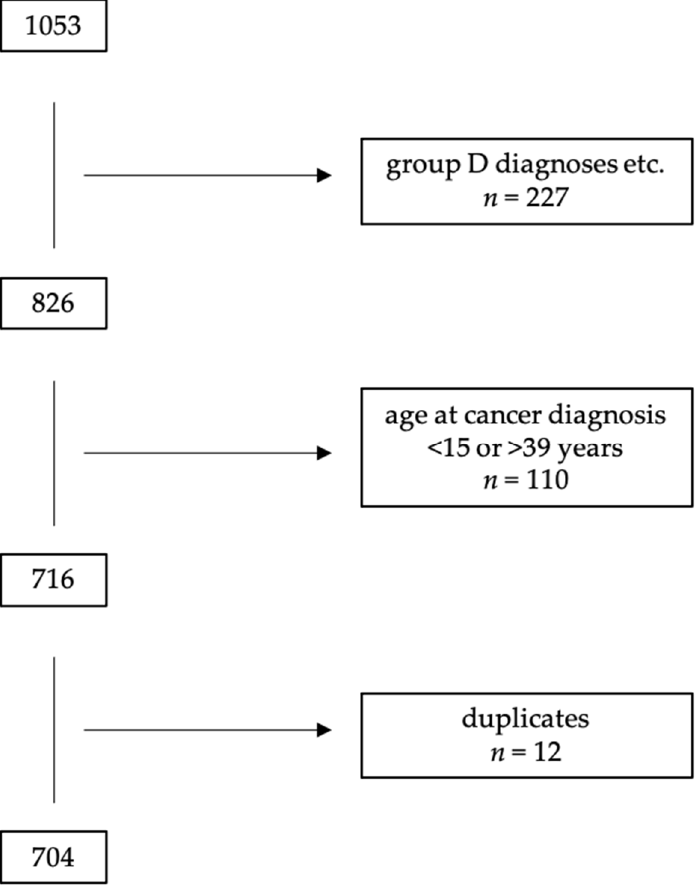
Figure 1. Consort diagram. Group D diagnoses: in-situ neoplasm, benign neoplasm, neoplasm of uncertain behavior.